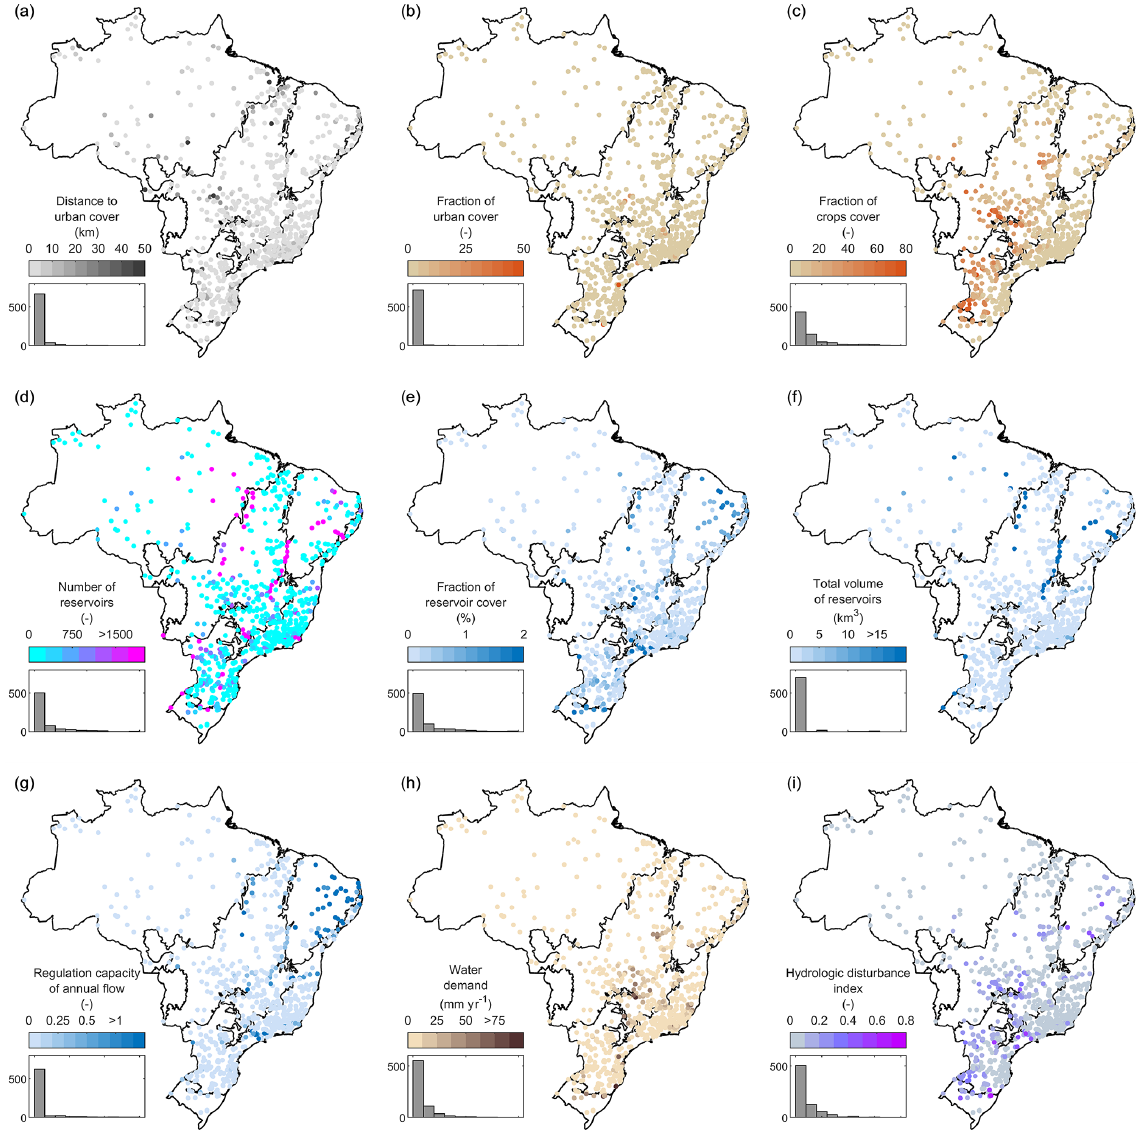
Figure 13. Spatial distribution of the hydrologic disturbance attributes of CABra catchments. (a) Distance from urban cover to the streamflow gauge (in km); (b) urban fraction of land cover (in percent); (c) crops fraction of land cover (in percent); (d) the number of reservoirs in the catchment; (e) reservoir fraction of land cover (in percent); (f) the total volume of the reservoirs in the catchment (in km 3 ); (g) the capacity of the reservoirs in the catchment to regulate the mean annual streamflow (dimensionless); (h) multi-purpose water demand in the catchment (in mmyr − 1 ); (i) hydrologic disturbance index (HDI) of the catchment (dimensionless). The HDI is a weighted relationship between all the anthropogenic factors of the